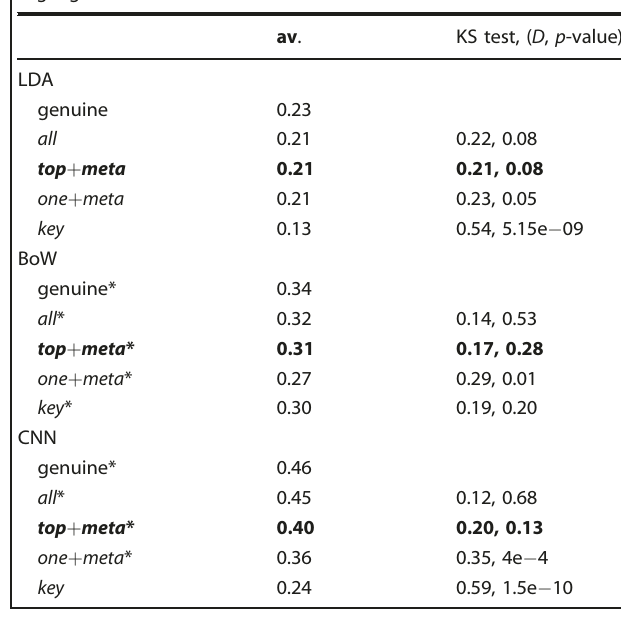
Table 8. Text classi fi cation results (averaged F 1-scores) for test-class- mimic . We use 2S-KS test for (a) comparisons between different models trained with the same type of data. * Marks statistically signi fi cant improvements for LDA over BoW, and for CNN over LDA ( α = 0.05, n 1 = n 2 = 65); and (b) comparisons within a model trained with the different types of data (column KS test). Models using less than all key phrases that provided results closest to those with real data are highlighted in